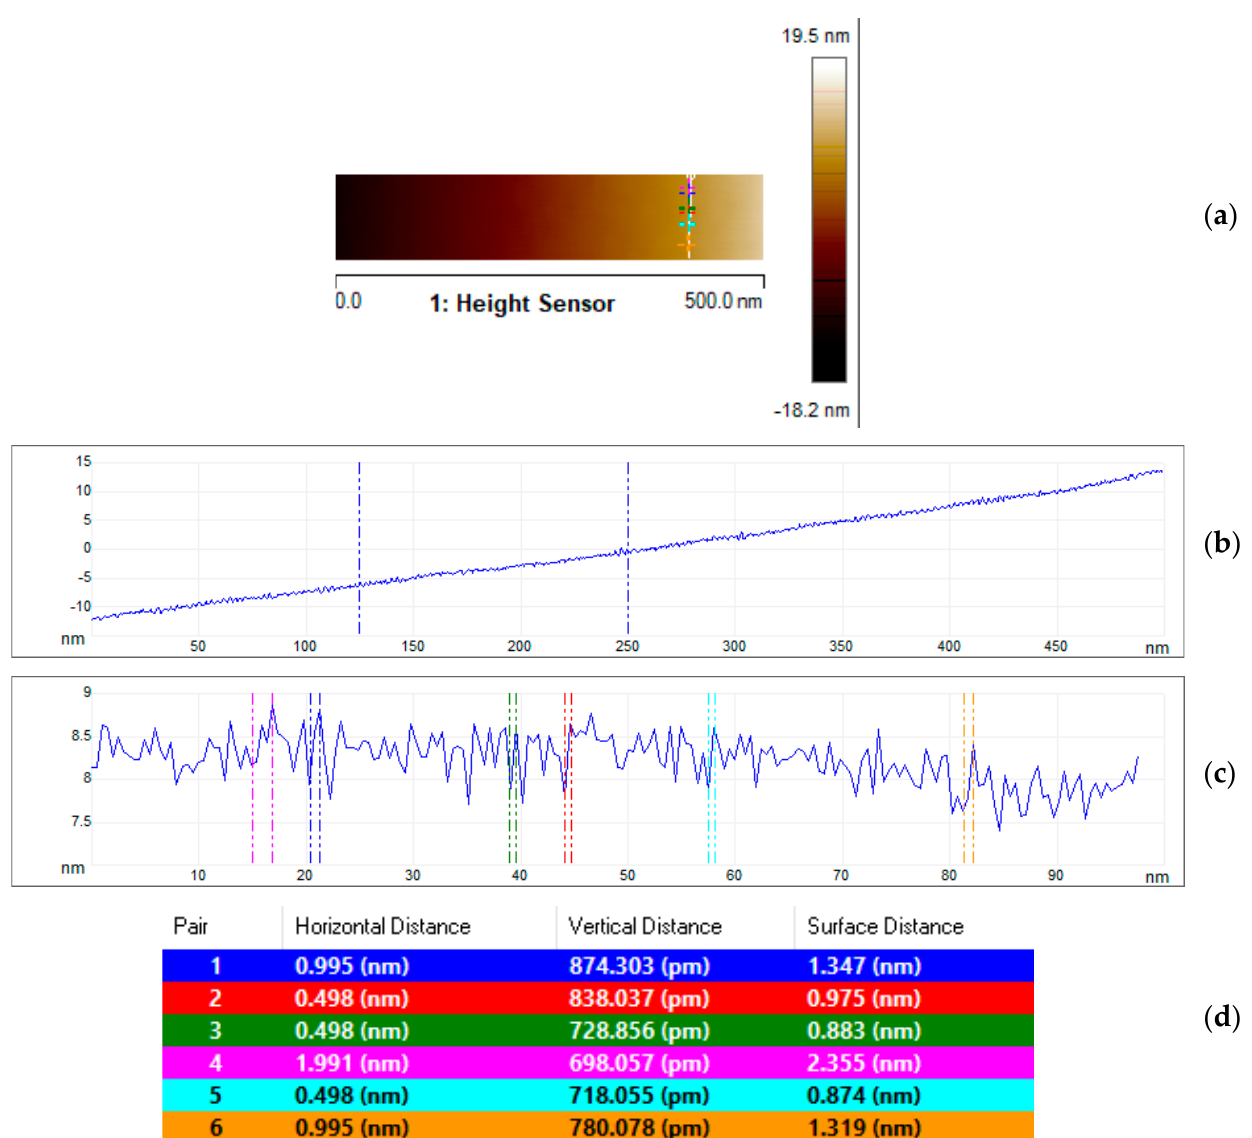
Figure 7. Result of the AFM scanning of sub-area S1: ( a ) scan of sub-area S1; ( b ) horizontal section of the scan of the Scheme 1; ( c ) cross-section of the scan of sub-area S1, the position of which is indicated by the white line in Figure 4a; ( d ) table of horizontal and vertical distances between markers indicated in Figure 4c.